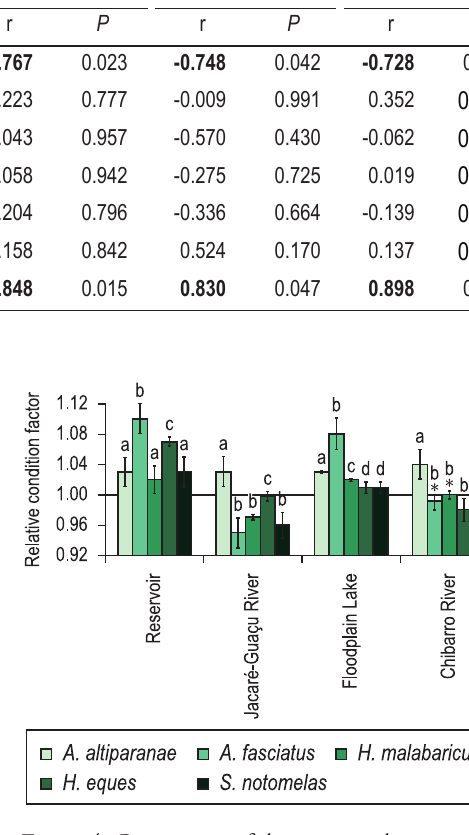
Figure 4. Comparison of the average relative condition factors (with standard error) of the five species, pooling the data of the two periods, in the four habitats: a) The reservoir of Gavião Peixoto Dam; b) Jacaré-Guaçu River; c) floodplain lake; d) Chibarro River. Different letters above bars indicate significant differences among Kn of each species in the habitat ( post hoc Tukey test, P < 0.05), and * indicates no statistical difference from 1 (Student’s t-test, P < 0.05); the gray line indicates the default value (Kn =